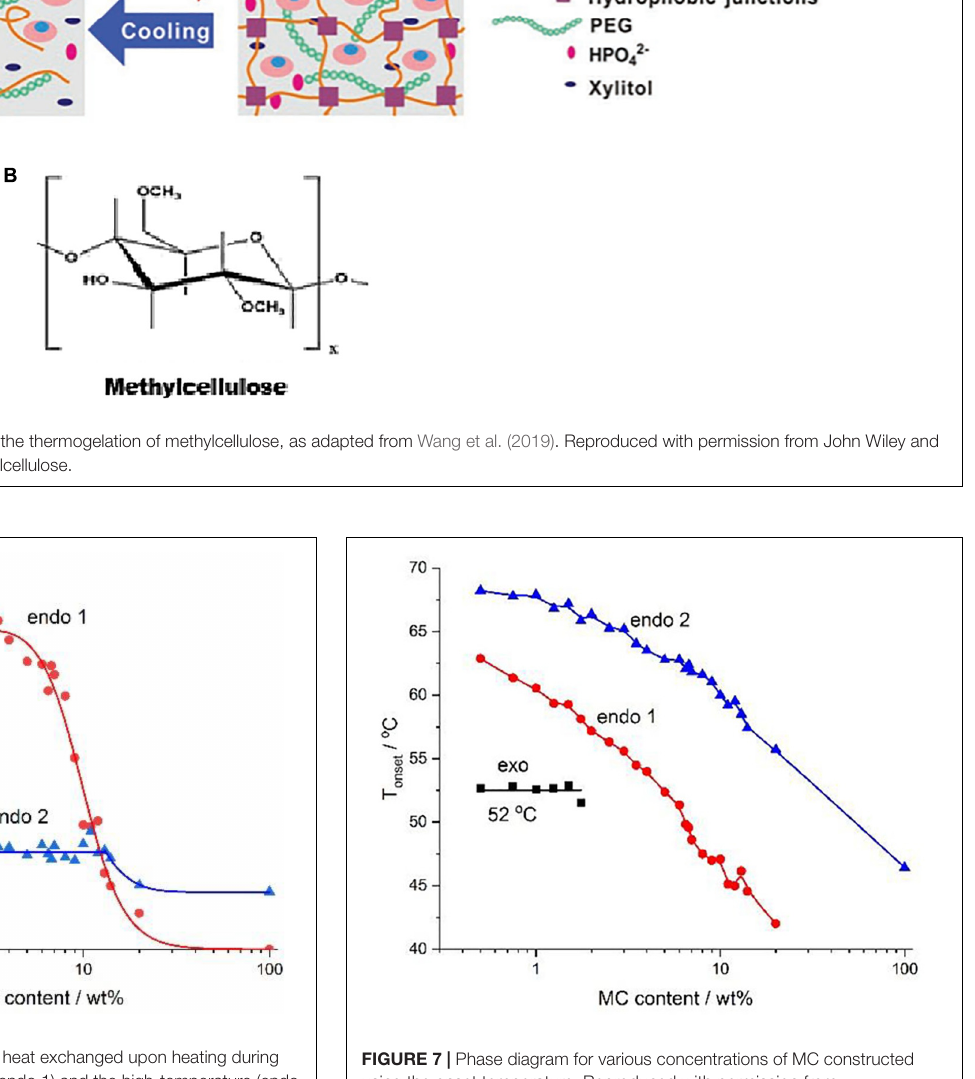
FIGURE 7 | Phase diagram for various concentrations of MC constructed using the onset temperature. Reproduced with permission from Niemczyk-Soczynska et al. (2019). Copyright 2019